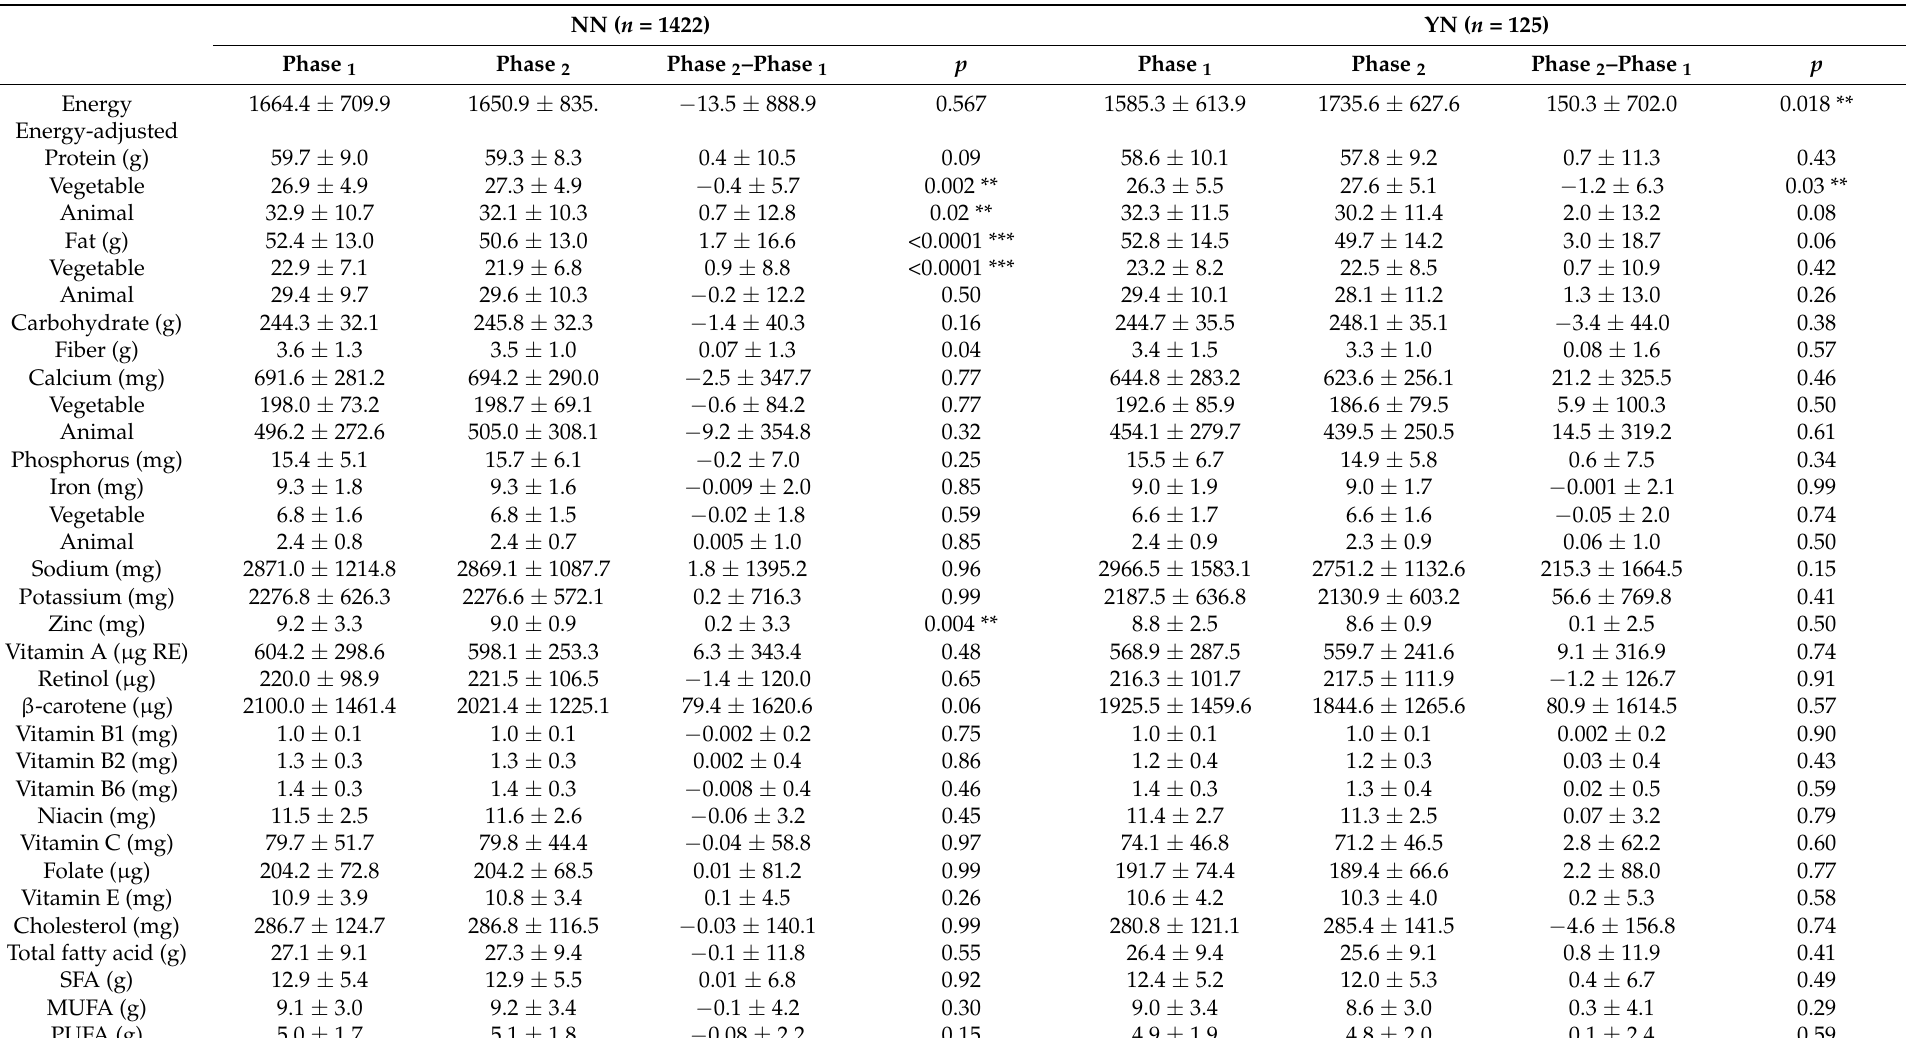
Table 4. Nutrient intake levels for four ADHD